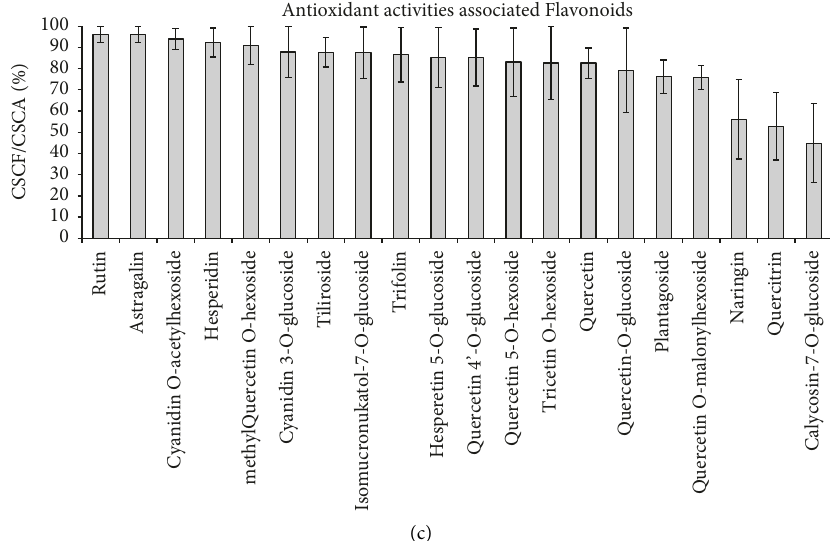
Figure 7: Detailed Proportion of antioxidant activities associated metabolites in flower compared to root, stem, leaf, and fruit. (a) Antioxidant activities associated amino acid and its derivatives. (b) Antioxidant activities associated organic acid and its derivatives. (c) Antioxidant activities associated flavonoids. CSCF/CSCA the contents of one specific component in flower to the contents of this component in all of root, stem, leaf, flower, and